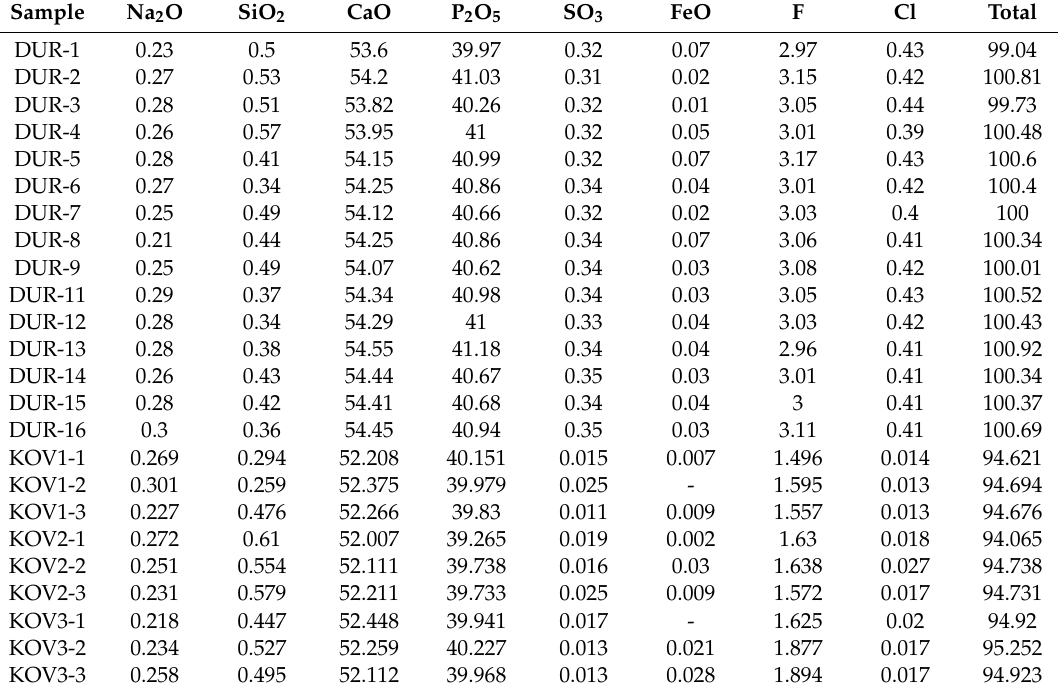
Table 2. Representative EMPA major-element composition of Durango and Kovdor apatite.